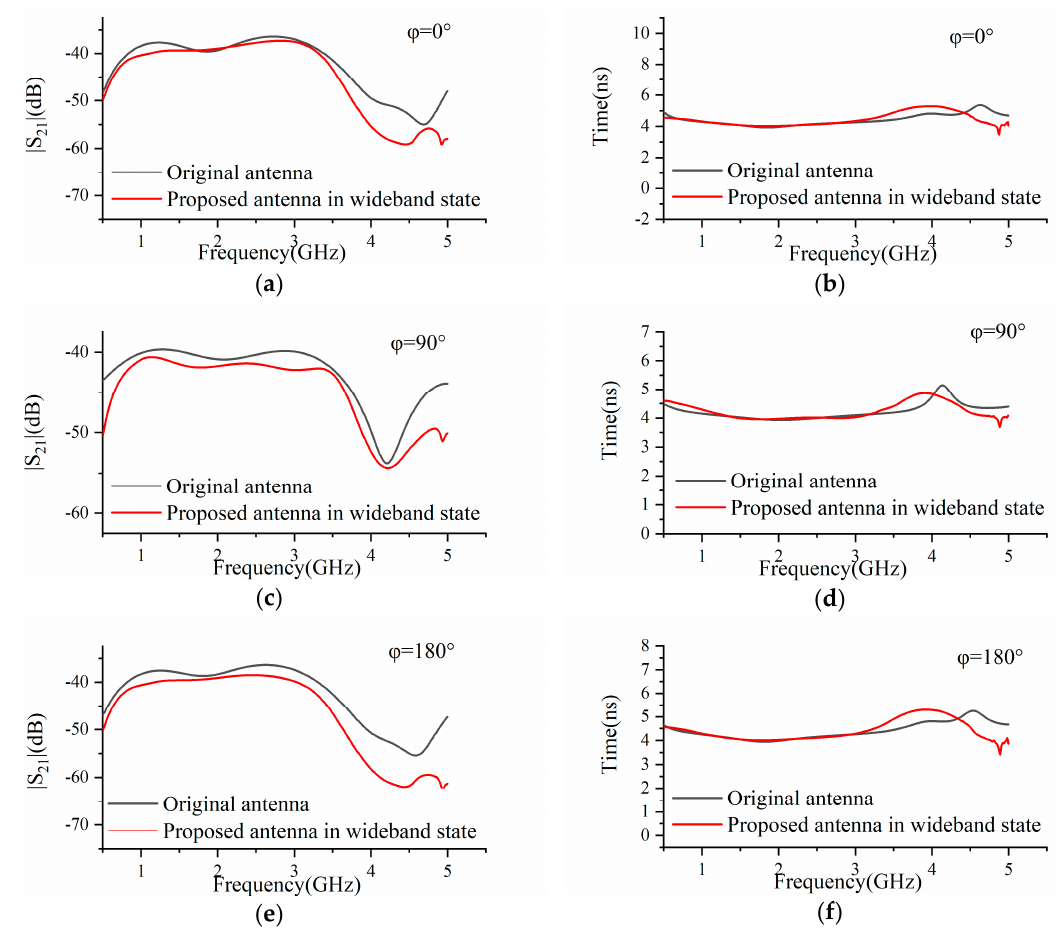
Figure 11. Measurement summary of S 21 magnitude and group delay for the original and proposed antennas at various φ : ( a ) S 21 magnitude and ( b ) group delay at φ = 0°, ( c ) S 21 magnitude and ( d ) group delay at φ = 90°, and ( e ) S 21 magnitude and ( f ) group delay at φ = 180°.